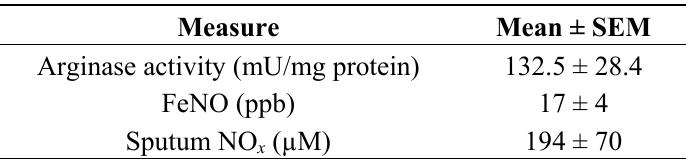
Table 2. Sputum in vitro arginase activity, sputum nitrate + nitrate (NO in COPD